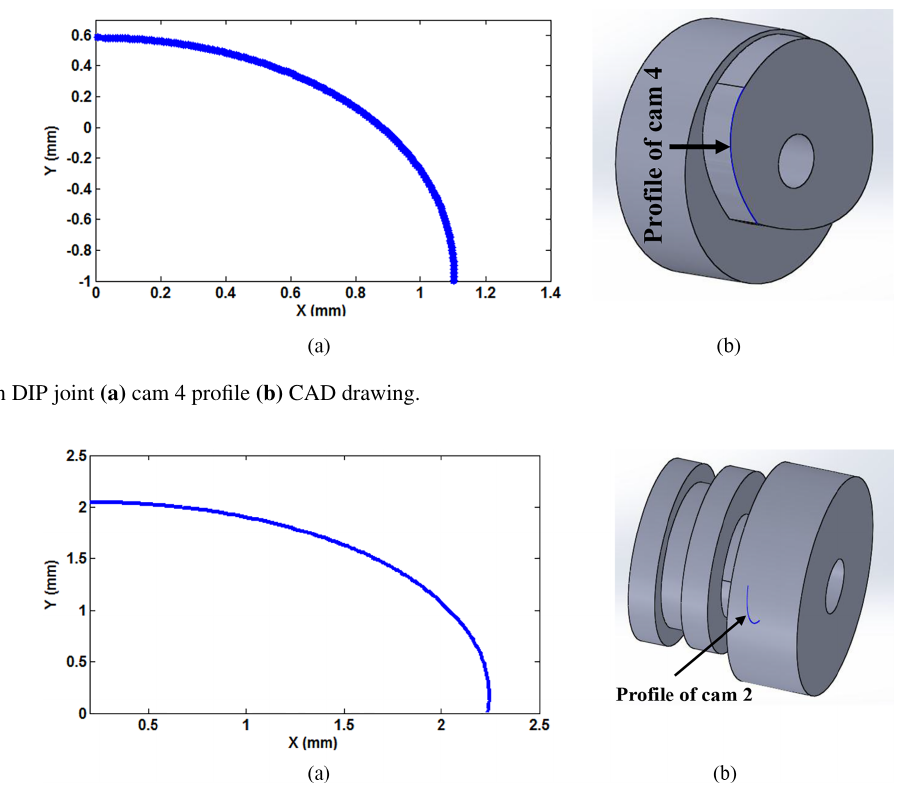
Figure 7. Double cam pulley on PIP joint (a) cam 2 profile (b) CAD